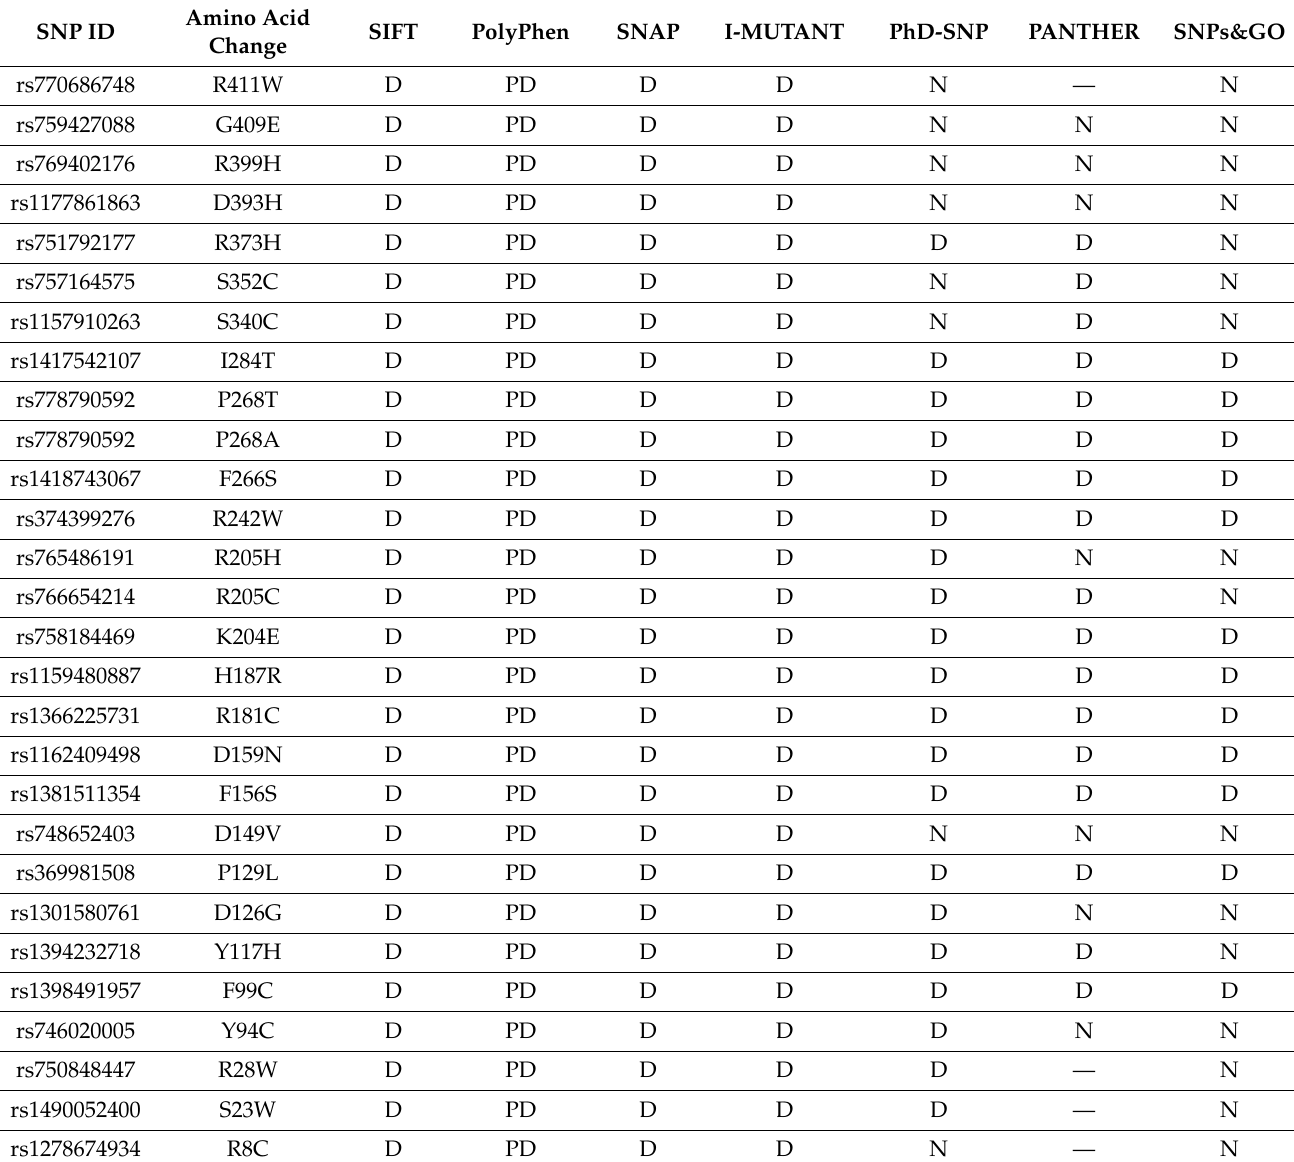
Table 1. Twenty-eight nsSNPs were predicted by SIFT, PolyPhen-2, SNAP, I-Mutant, PhD-SNP, PANTHER, and SNP&GO. SNP